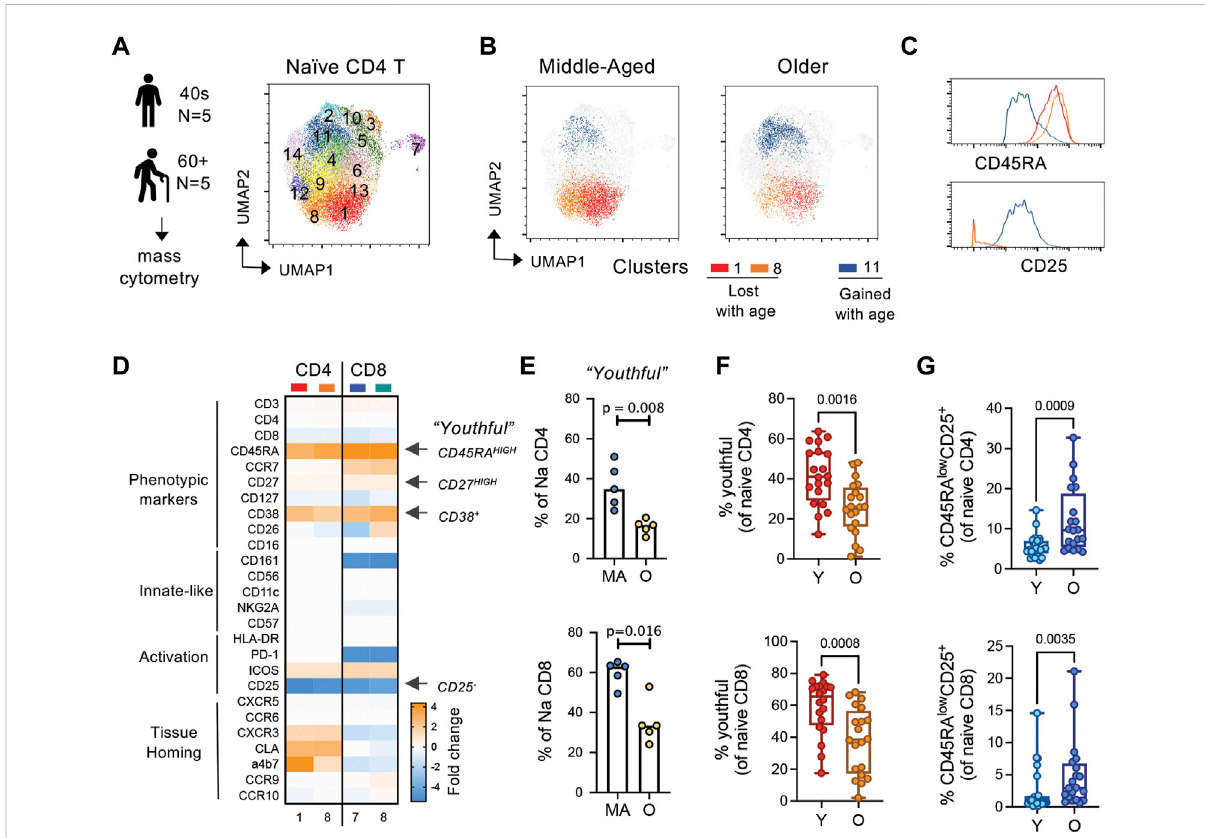
FIGURE 4 CD45RA high subset of naïve T cells is replaced by a CD45RA low , CD25 low/+ subset with age. (A) General experimental outline and Phenograph clustering of naïve CD4 T cells from middle-aged (MA; n = 5; 40 – 49 years) and older (OA; n = 5; > 60 years) adults. (B) UMAP of differential clusters between MA and OA naïve CD4 T cells. (C) Histograms of select markers delineating age-related clusters. (D) Relative markers expression in naïve CD4 and CD8 clusters that decrease with age compared with those that increase with age. (E) Hand-gated frequencies of population lost